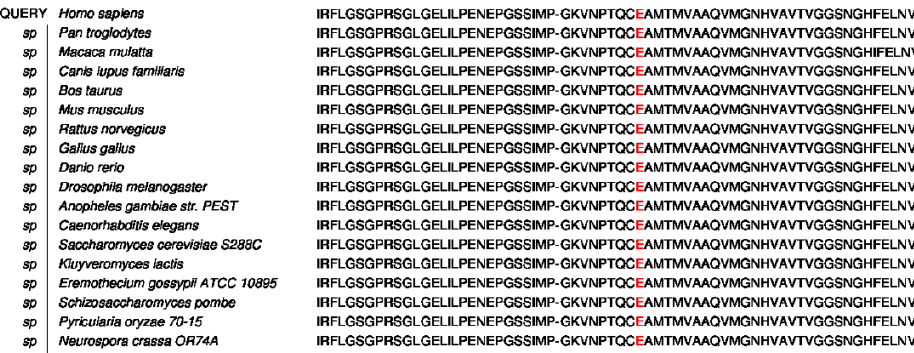
Figure 6. The missense mutation c.1132G > A (p.E378K) in exon 8 is highly conserved among 17 species.